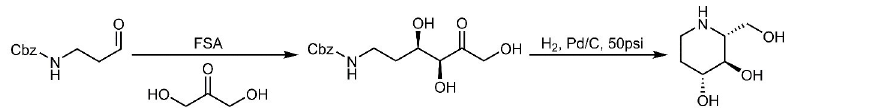
Fig 1. Enzymatic system for the synthesis of